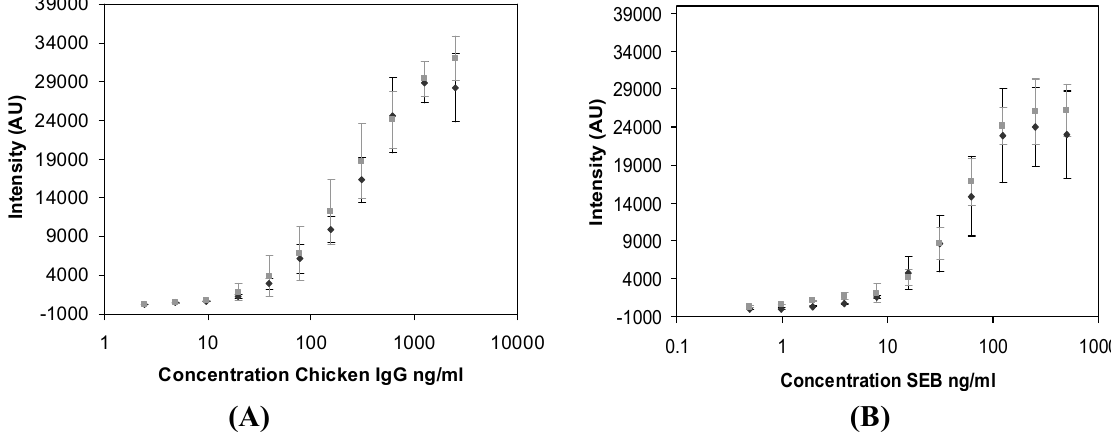
Figure 2. Single format NC tracers versus Cy5 tracer. (A) Chicken immunoassay, microtiter well plate functionalized with single species capture antibodies for chicken IgG; the tracer was either 10 μg/mL Cy5 rabbit-anti-Chicken IgG (  ) or NC605-rabbit-anti-Chicken IgG (  ) at 1:400 dilution. (B) SEB immunoassay, microtiter well functionalized with single species capture antibodies for SEB; the tracer was either 10 μg/mL Cy5 rabbit-anti-SEB (  ) or NC650-rabbit-anti-SEB (  ) at 1:100 dilution. Intensity measurements were recorded at the emission maxima (Em) for each of the particular fluorescent labels: NC605 Ex@400 nm, Em@605 nm; NC650 Ex@400 nm, Em@650 nm; Cy5 Ex@650 nm, Em @670 nm (n ≥ 4, for all data).